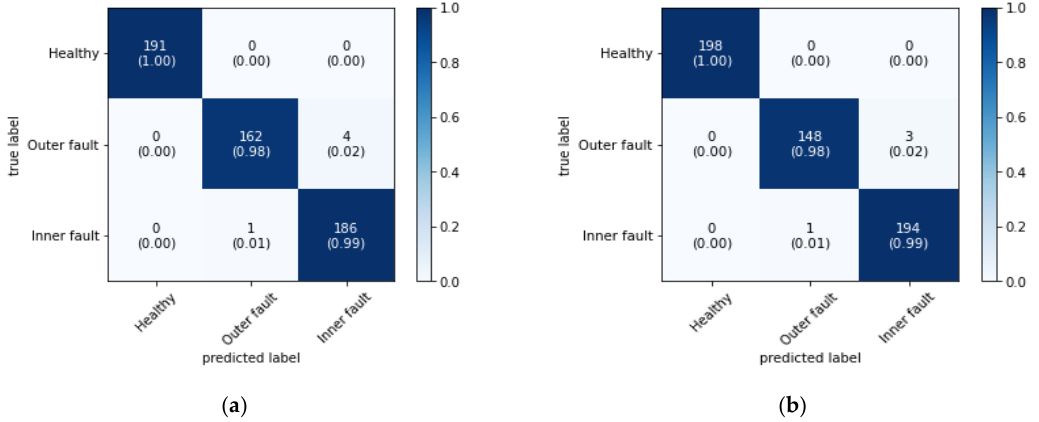
Figure 13. Confusion matrix of the db4 wavelet for ( a ) RF and ( b ) XGBoost classifiers.